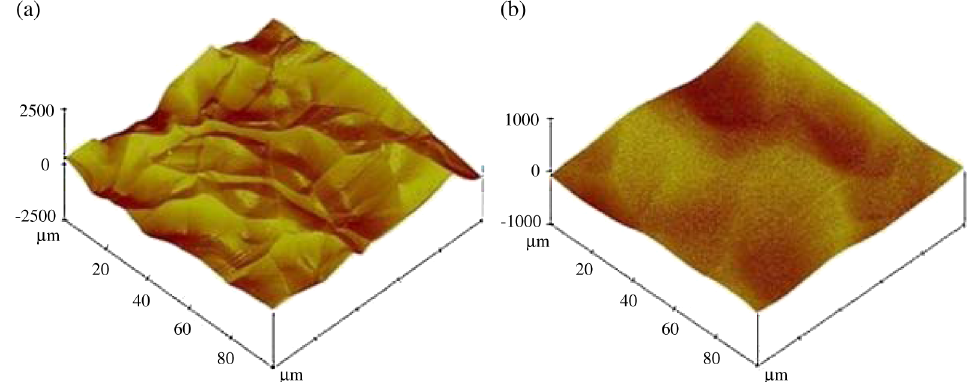
FIG. 15. AFM images of fine-grained material after (a) 100 (cid:1) m removal by BCP or (b) 50 (cid:1) m removal by EP. The horizontal scale is 100 (cid:1) m by 100 (cid:1) m for both. Vertical scales are 2500 and 1000 nm for (a) and (b), respectively.